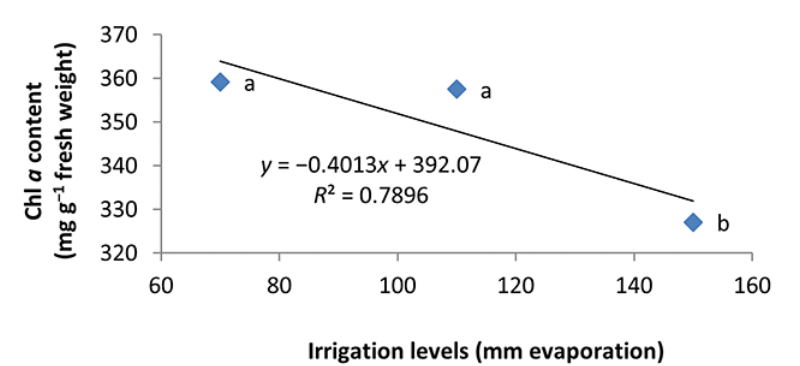
Figure 1 Effect of different irrigation levels on chlorophyll a (Chl a ) content in